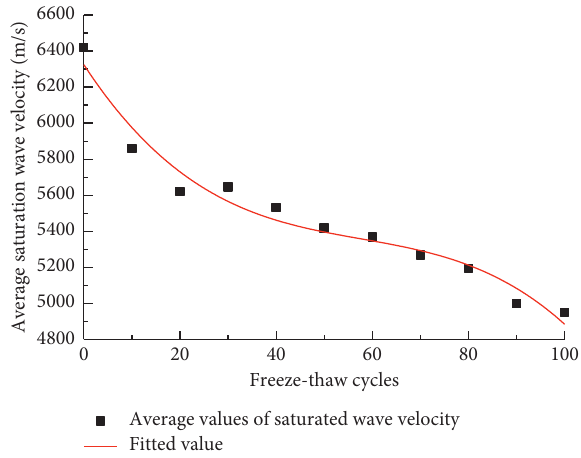
Figure 8: Variation of mean saturation wave velocity under dif- ferent freeze-thaw cycles.